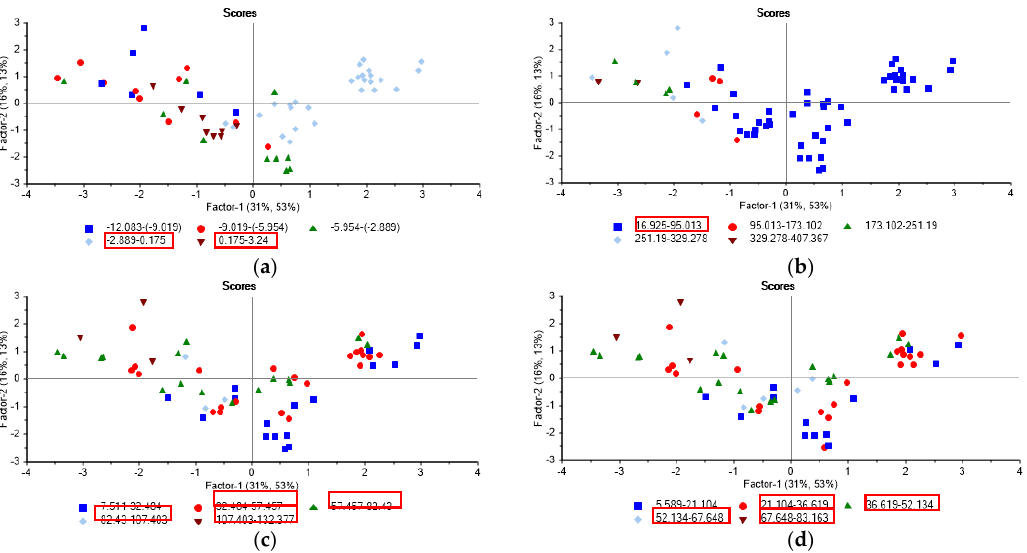
Figure 14. Results of partial least squares analysis (PLS) for the tested membrane flux enhancers—scores plot with the sample grouping according to: ( a ) zeta potential; ( b ) CST; ( c ) D[4,3]; ( d ) D[3,2].